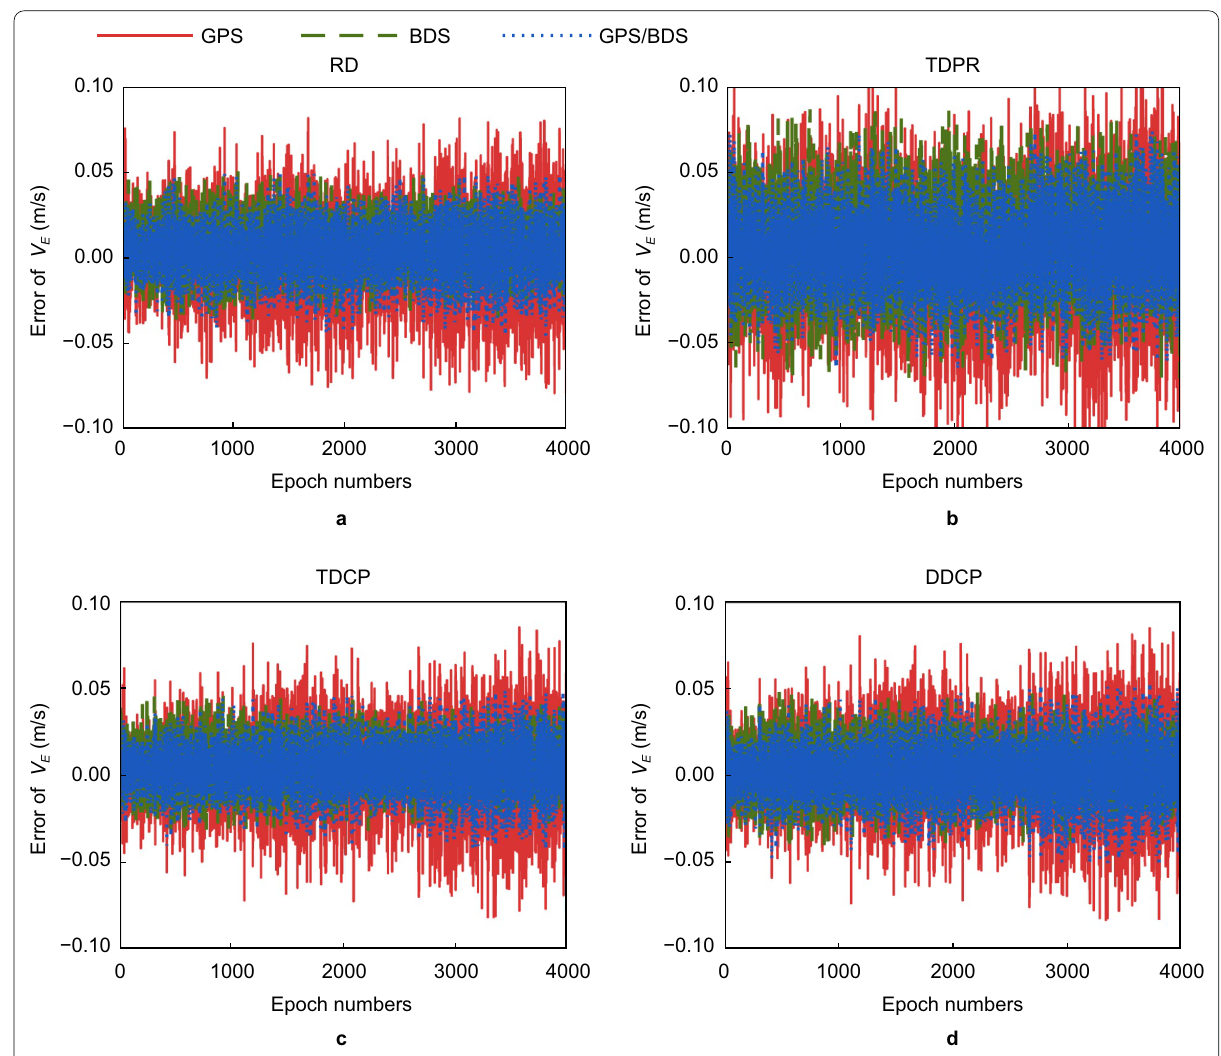
Fig. 1 Velocity determination results in east component with the RD- ( a ), TDPR- ( b ), TDCP- ( c ) and DDCP- ( d ) based methods in a static